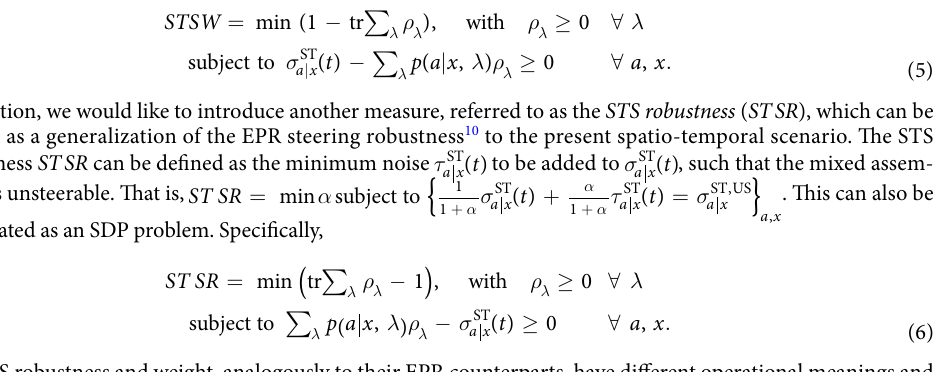
(the same techniques have been demonstrated in refs 9, 44). σ